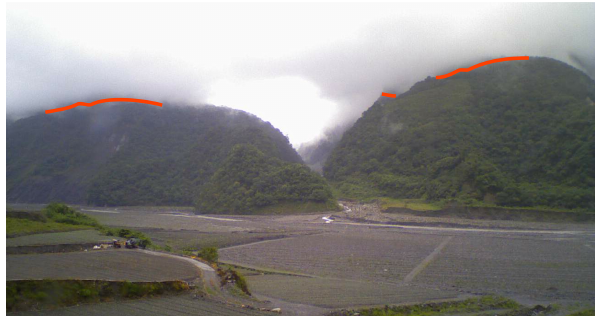
Figure 12. Manual identification of cloud base heights on Chi- Lan Mountain using PlotWatcher Pro imagery (scene from 31 Au- gust